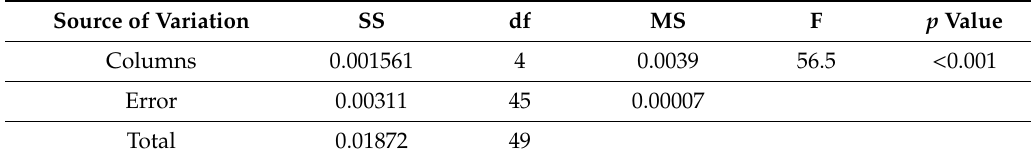
Table 7. One-way analysis of variance test details for the individual classifiers and their